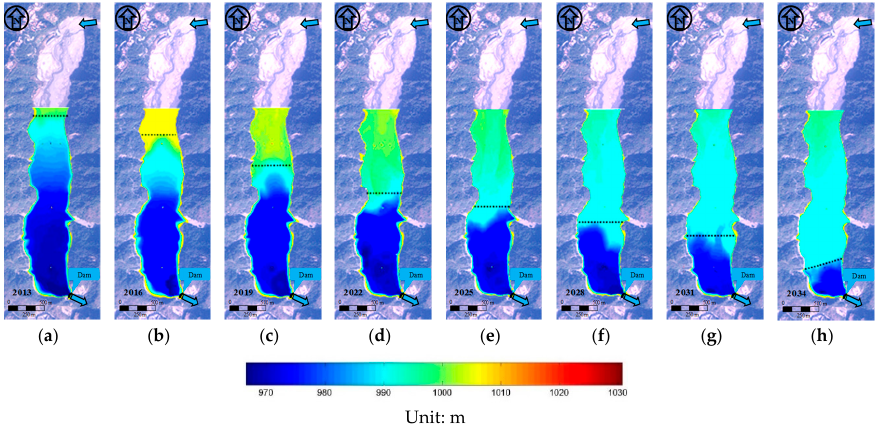
Figure 6. Deposition delta movement patterns from 2013 to 2034. ( a ) 2013; ( b ) 2016; ( c ) 2019; ( d ) 2022; ( e ) 2025; ( f ) 2028; ( g ) 2031; ( h ) 2034. ( e ) 2025; ( f ) 2028; ( g ) 2031; ( h )